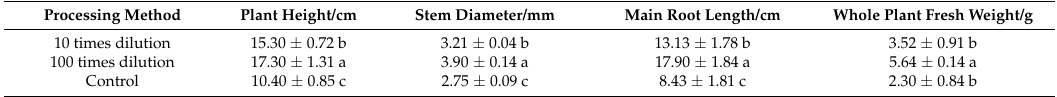
Table 6. The growth-promoting effect of single strain WXCDD105 on tomato seedlings.